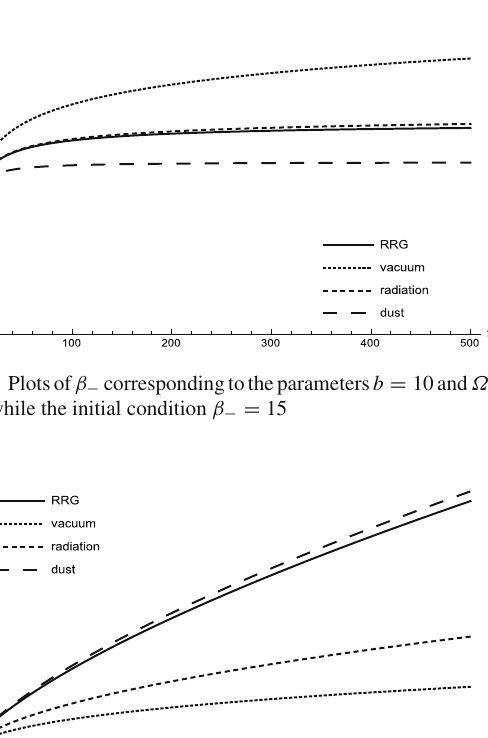
Fig. 2 Plots of Ω ani (τ) for the initial values of b = 10 and Ω ( i ) 0 . 99